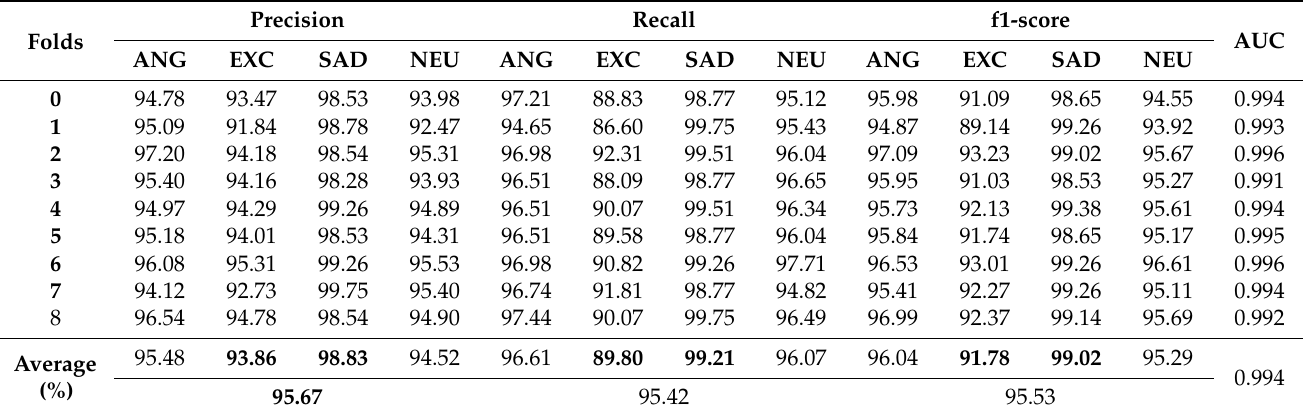
Table 11. Precision, recall, f1-score, and AUC for GRU model with 128 parameters. Precision Folds